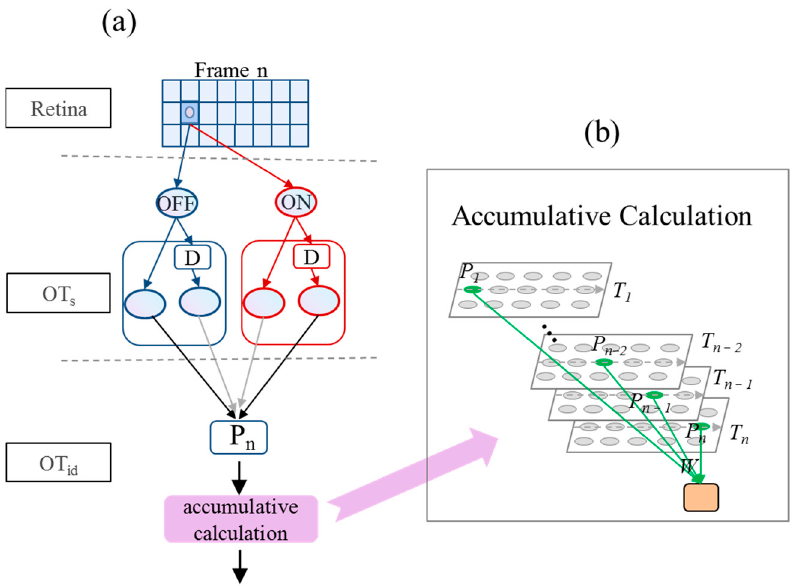
Figure 1. Schematic of the elementary motion detector with spatio-temporal information accumulation (EMD_TSA). ( a ) Schematic diagram showing the overall design of EMD_TSA. OT s : the superficial layers of optic tectum; OT id ; the intermediate-deep layers of optic tectum; D; the time delay unit. ( b ) Schematic illustration of spatio-temporal information accumulation along the motion direction. This figure is a visual example of Equation (21).